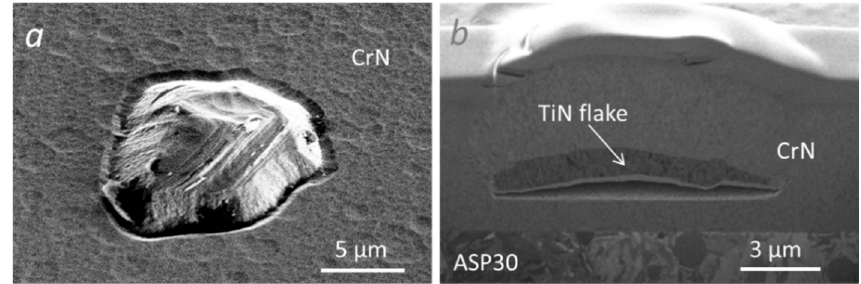
Figure 14. Top view SEM image ( a ) and FIB cross-section image ( b ) of flake defects in CrN hard coating prepared by evaporation using thermionic arc.